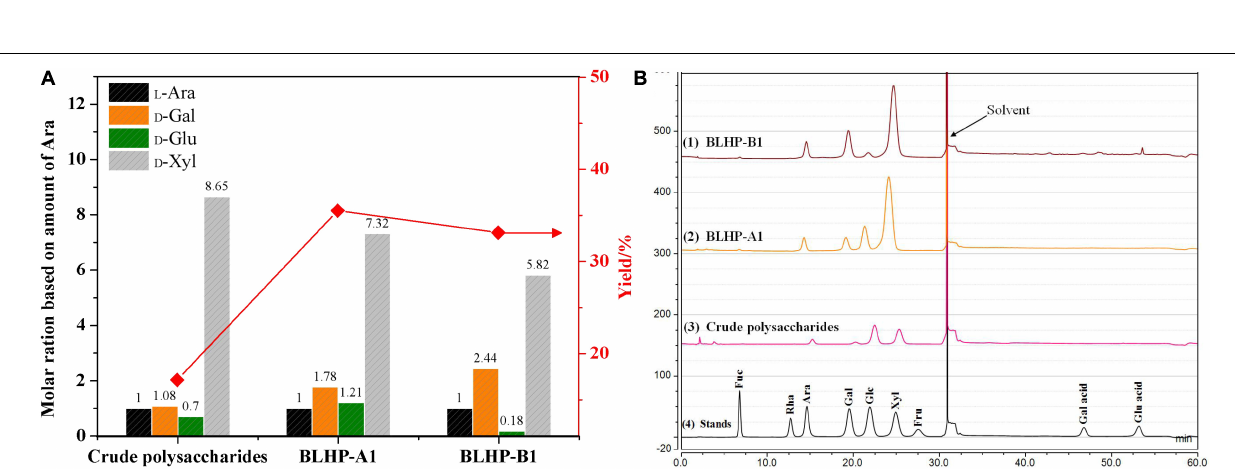
Frontiers in Nutrition |